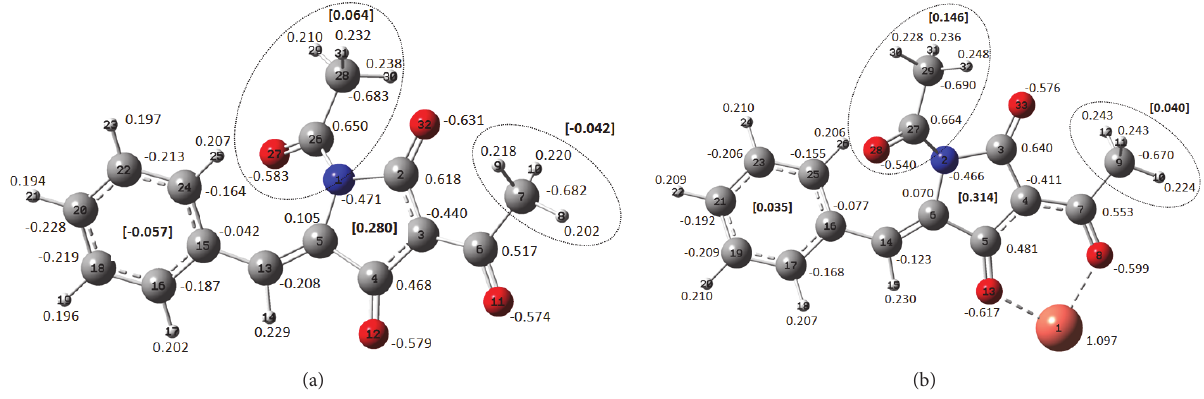
Figure 5: Atomic charges calculated by natural population analysis at B3LYP/TZVP level of theory of (a) N-acetyl-3-acetyl-5-arylidene- tetramic anion (TA-H + ) and (b) copper(II) complex (only a part of the structure is presented here). “Mean” charges of various groups are denoted as bold numbers in